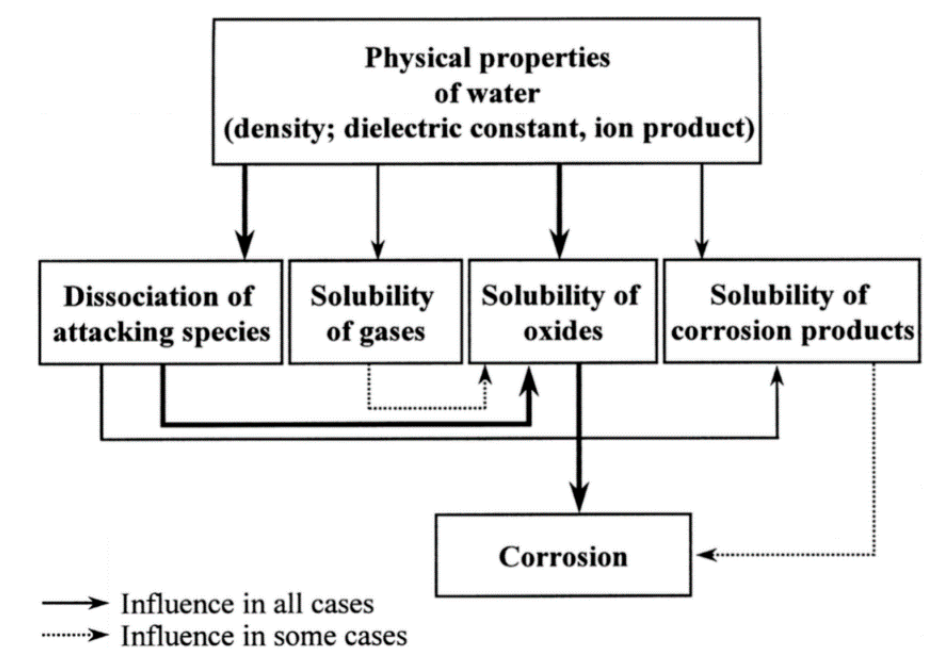
Figure 38. Interdependences of the corrosion-determining factors in high-temperature aqueous solutions. Reprinted with permission from Reference [109]. Copyright 1999 Elsevier.